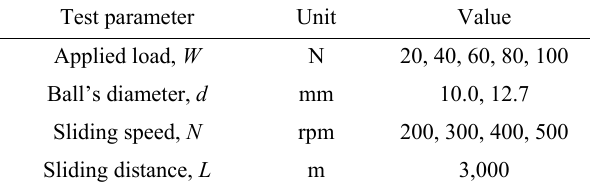
Table 2 Physical–mechanical properties of the ball and